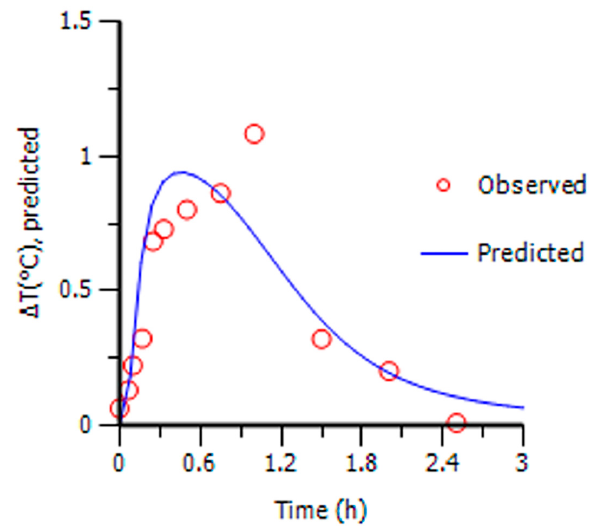
profiles for the two-compartment PK model.